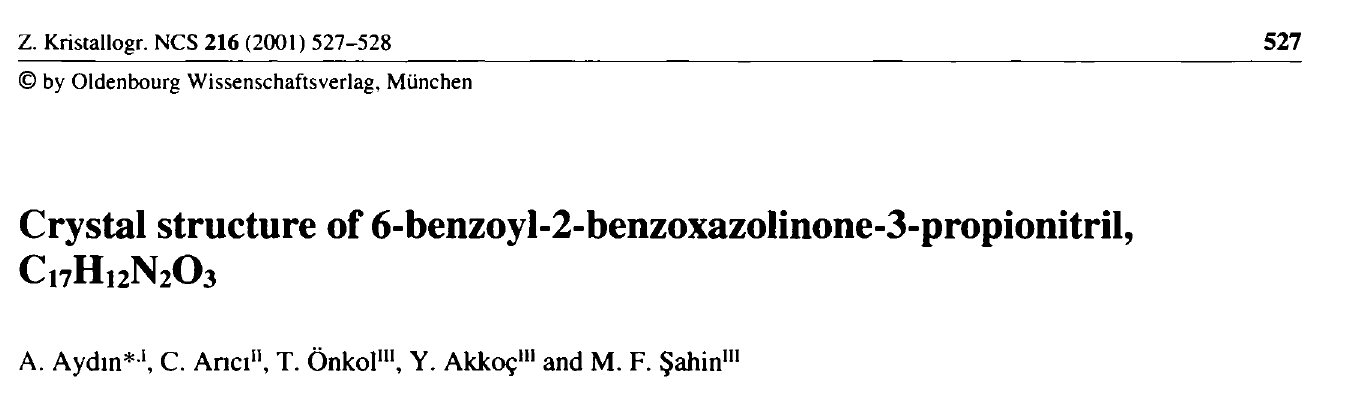
Table 1. Data collection and handling.